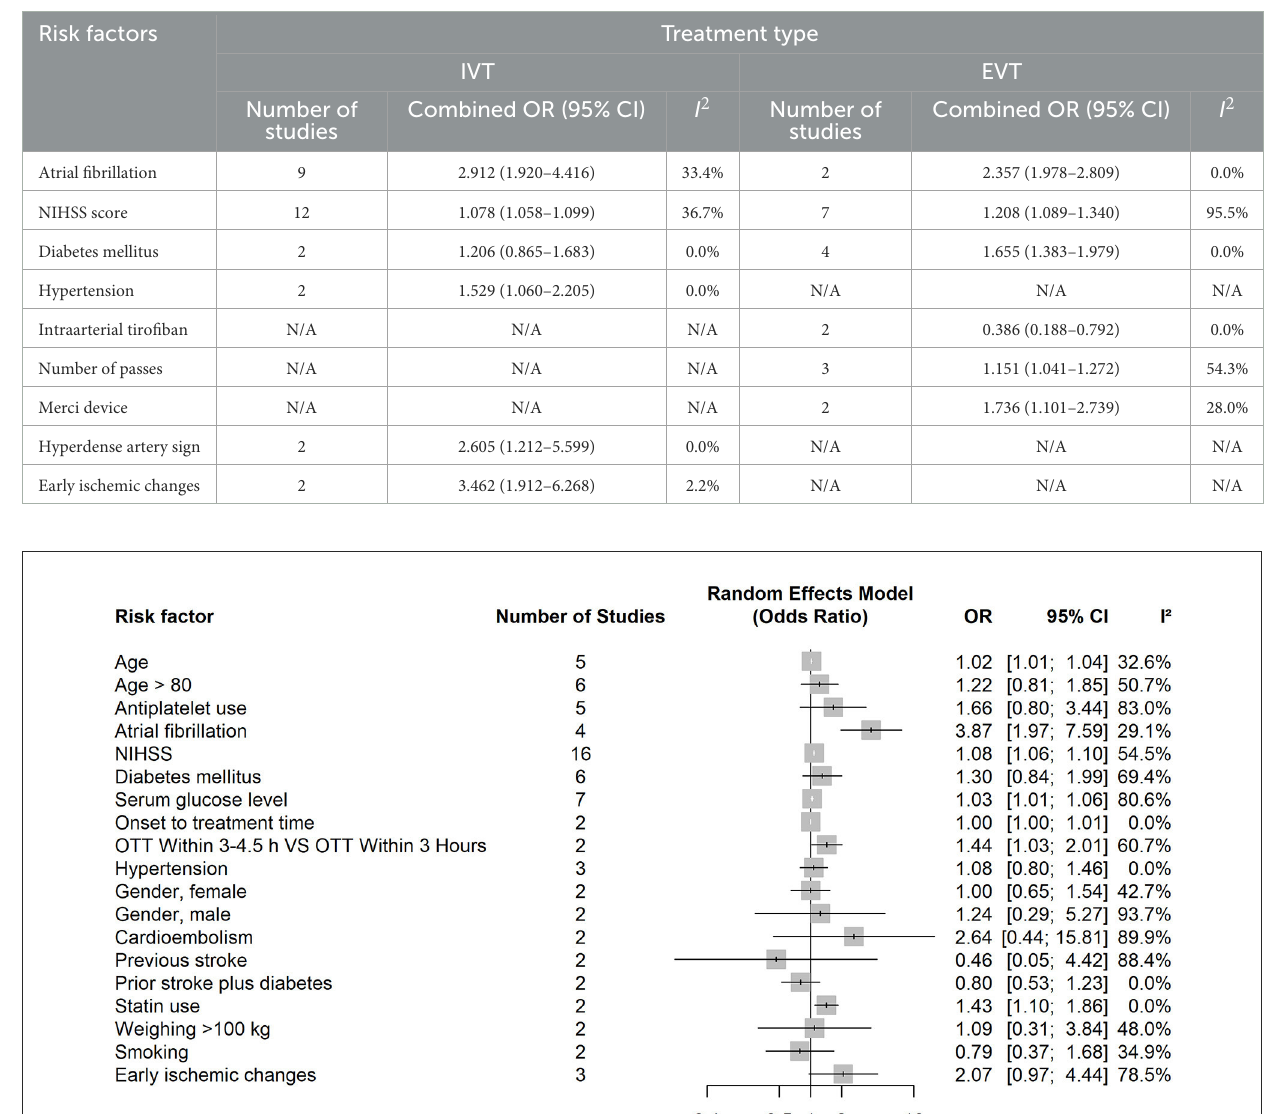
TABLE 4 Predictors for any ICH in acute ischemic stroke patients: IVT vs. EVT.